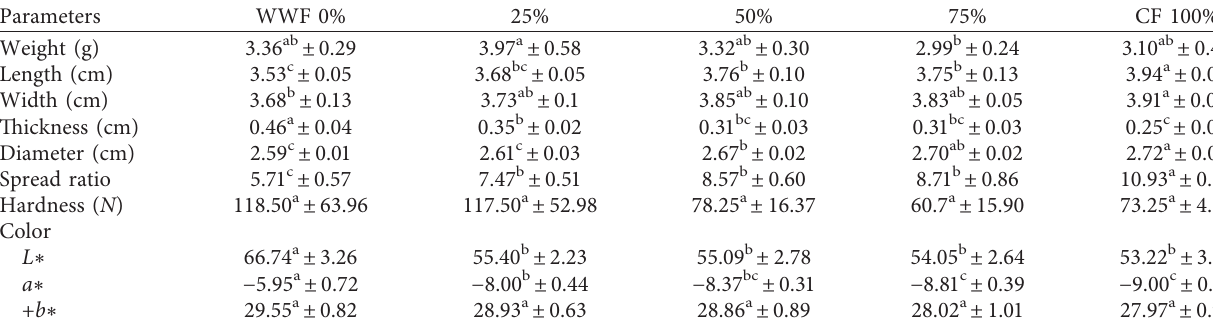
Table 5: Physical properties of composite